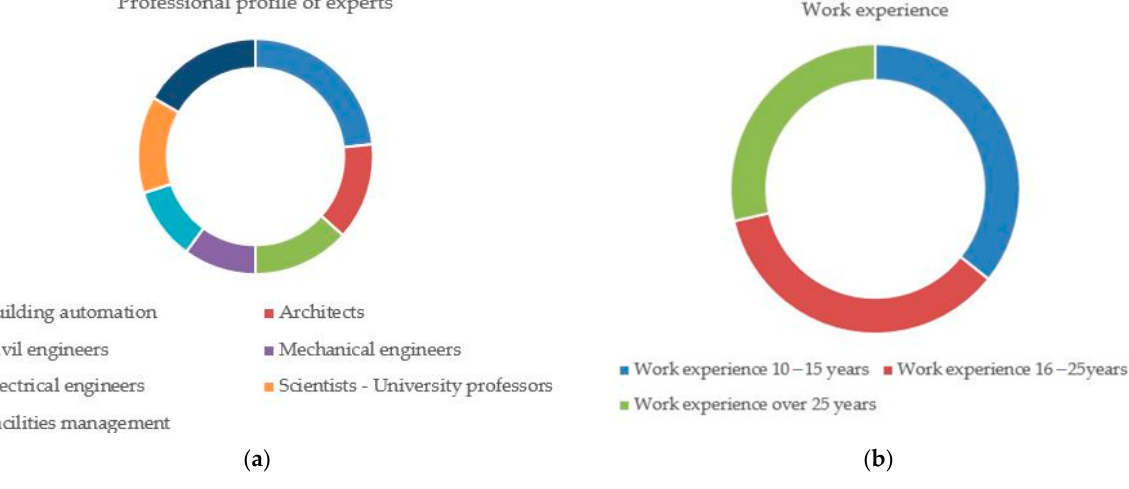
Figure 1. Background analysis of experts: ( a ) Professional profile; ( b ) Work experience.